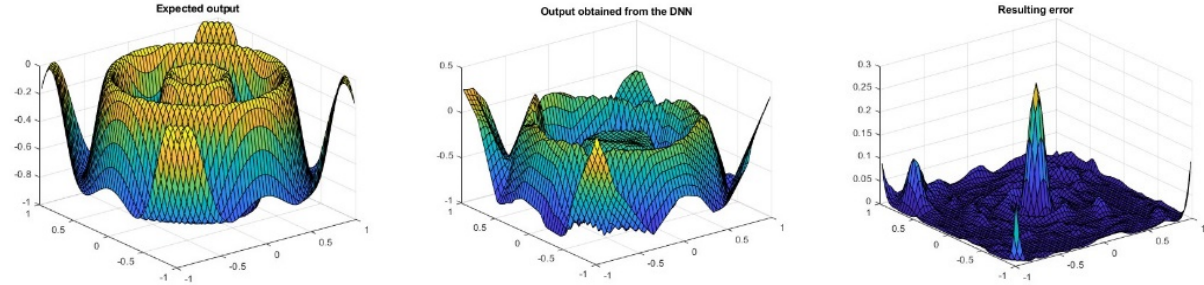
Figure 35. Expected output of the DNN for the Drop-Wave function on the left, the obtained results in the middle and the error on the right.